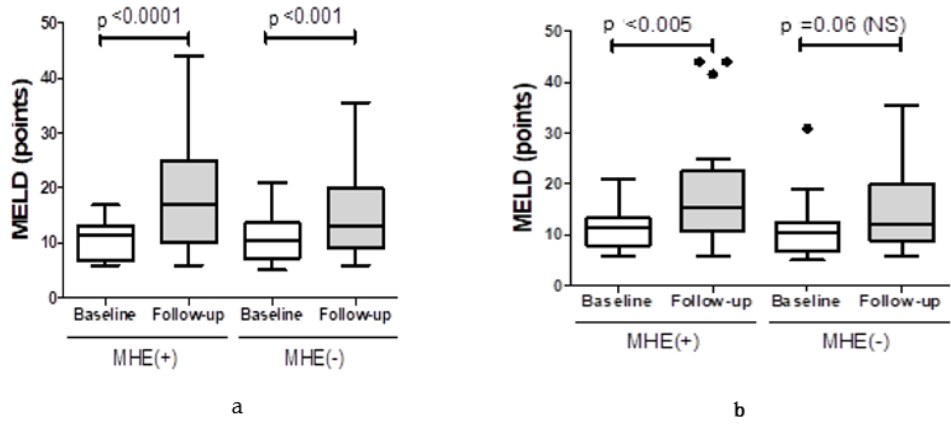
Figure 2. Comparison of baseline and follow-up MELD scores for end-stage liver disease in patients